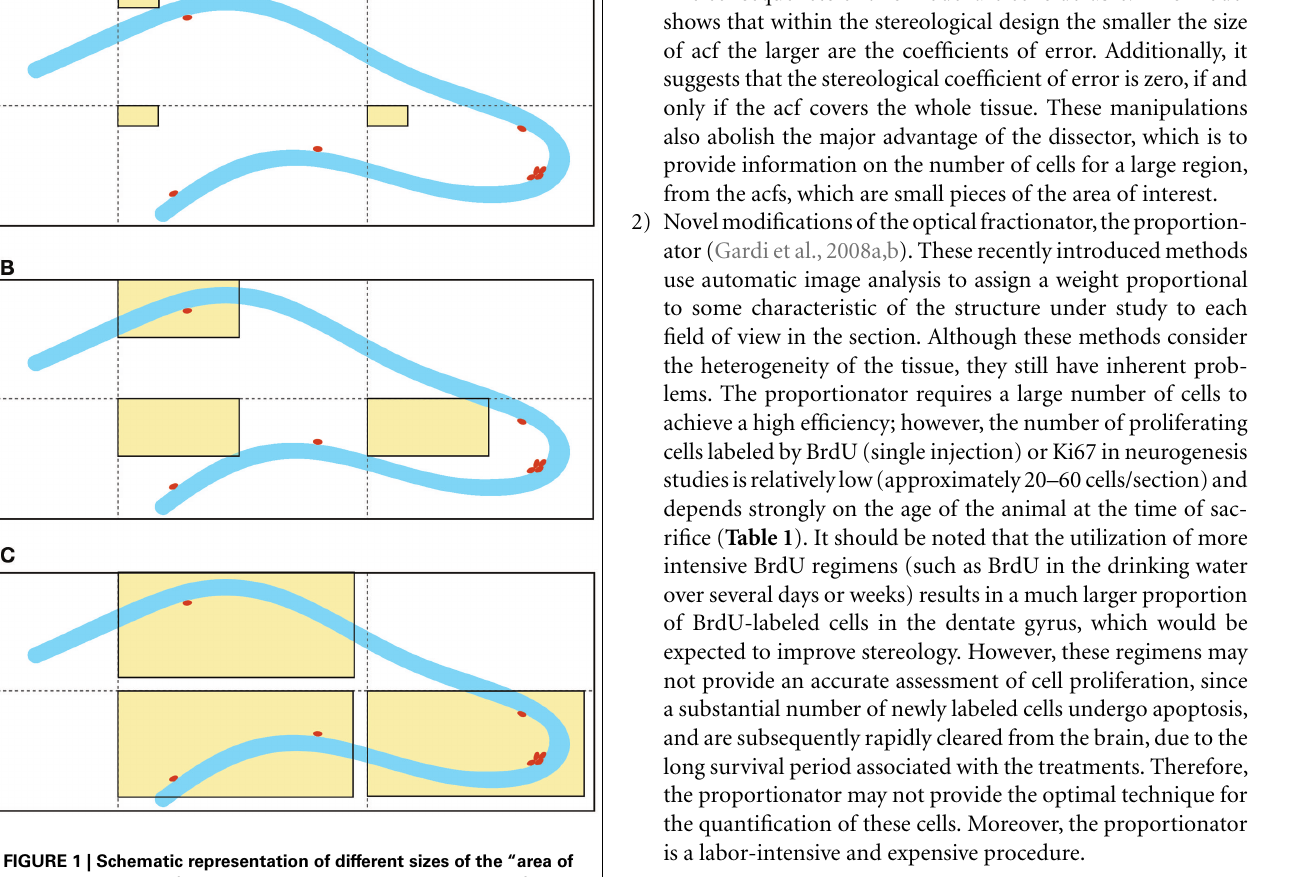
Table 1 |Age-related decline in the number of Ki67-positive cells and clusters in the dentate gyrus of saline-treated male Sprague-Dawley rats ( n = 8/group). Labeled cells/clusters were counted bilaterally and are expressed per cubic mil- limeter of tissue. Values are means ± SEM. Data are from Cowen et al. (2008). Clusters were defined as in the caption to Figure 2